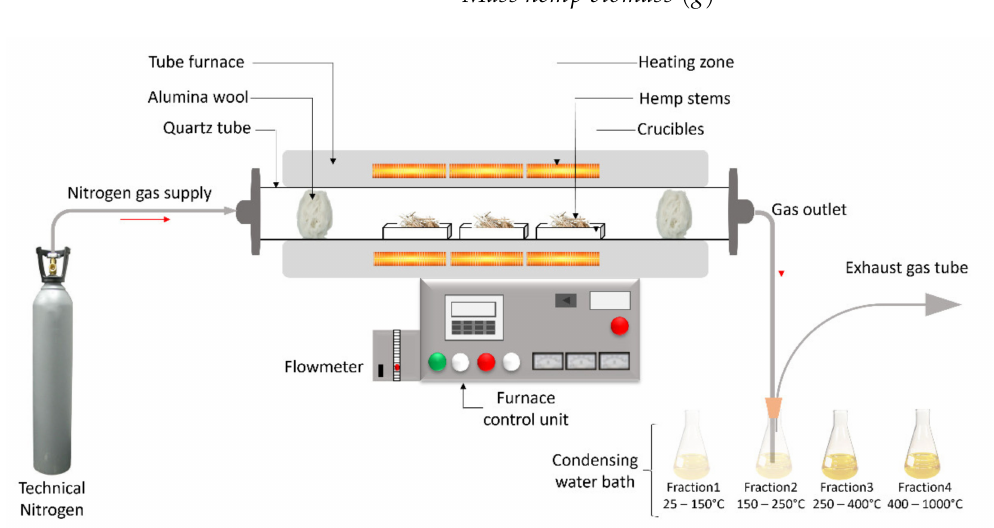
Figure 5. Schematic of the thermochemical conversion process and sampling of the aqueous